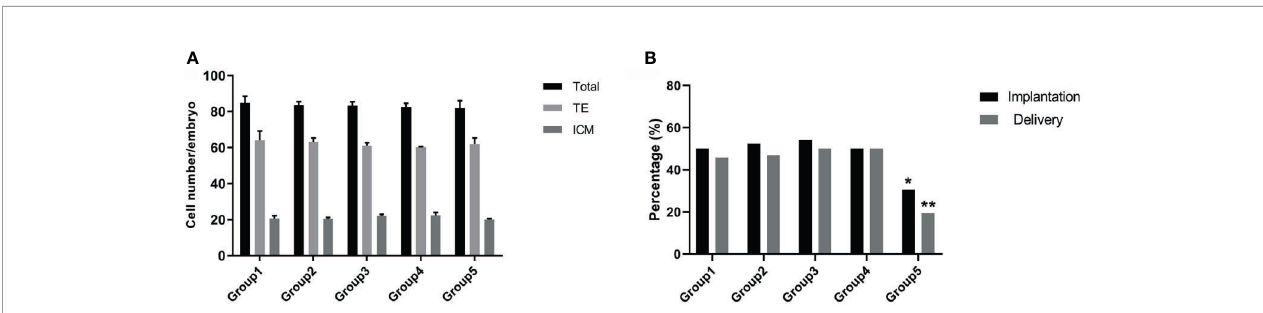
FIGURE 2 | Effect of re-vitri fi cation at different stages on the mouse embryonic development. (A) Blastomere numbers were not signi fi cantly different among the groups. Values are shown as the mean ± the standard error of the mean (SEM). (B) Group 5 showed a signi fi cant lower of implantation and delivery rates. Signi fi cant difference, *P < 0.05, **P < 0.01.